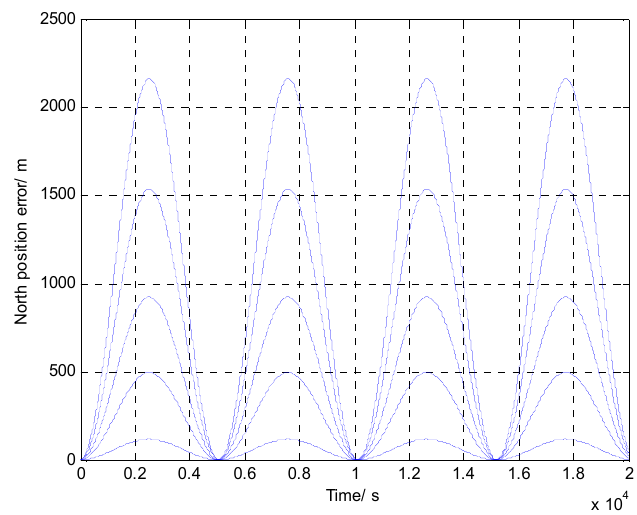
Figure 3. The north position error caused by gravity disturbance.